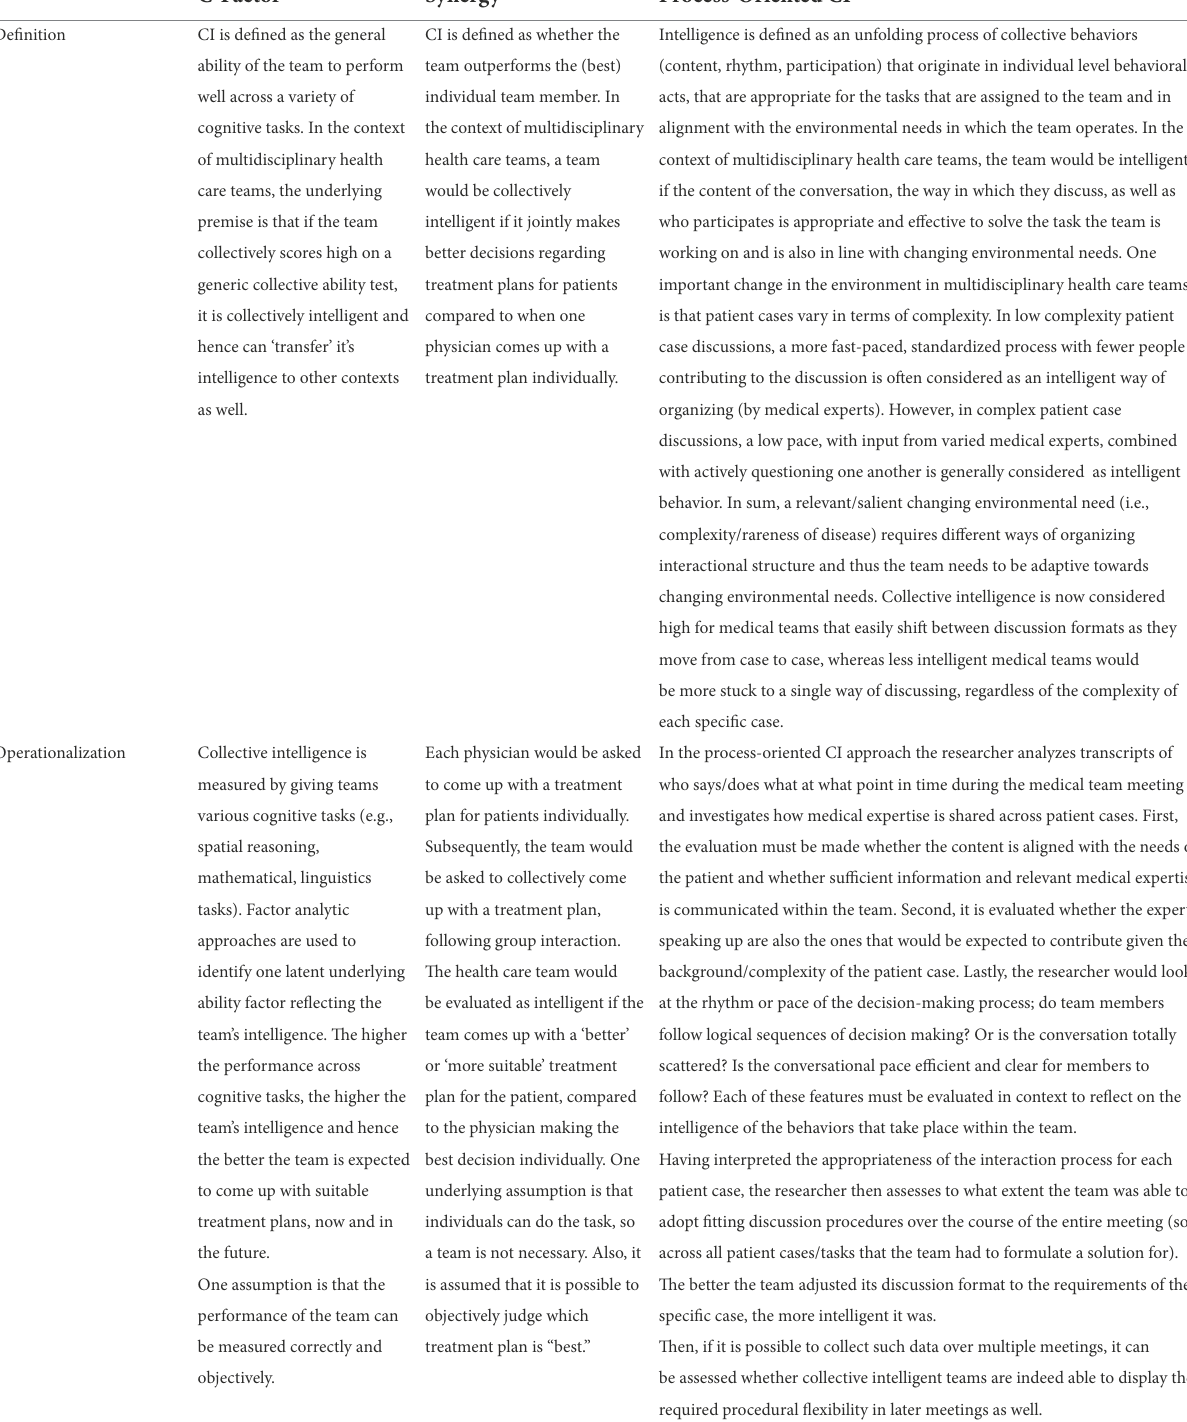
TABLE 3 Comparison of CI applications across c-factor, synergy as well as process-oriented view. C-Factor